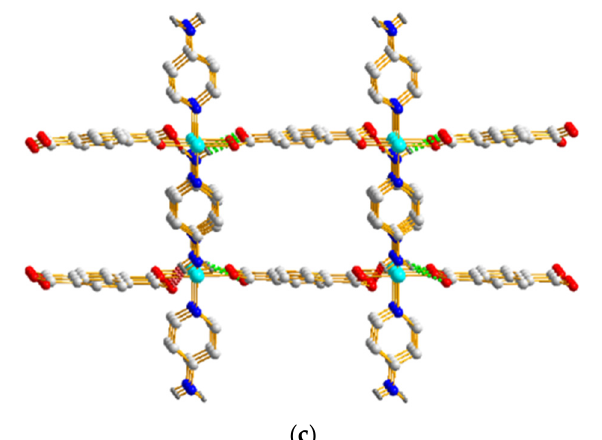
Figure 6. ( a ) Coordination environment of Cu(II) ion in 5b · H 2 O. Symmetry transformations used to generate equivalent atoms: (A) x, 1 − y, -0.5 + z. ( b ) The Cu(II) ions are linked by 1,4-BDC 2 − ligands to form 1D zigzag chains. ( c ) The chains are linked by the N-H—O hydrogen bonds to form a 3D framework.